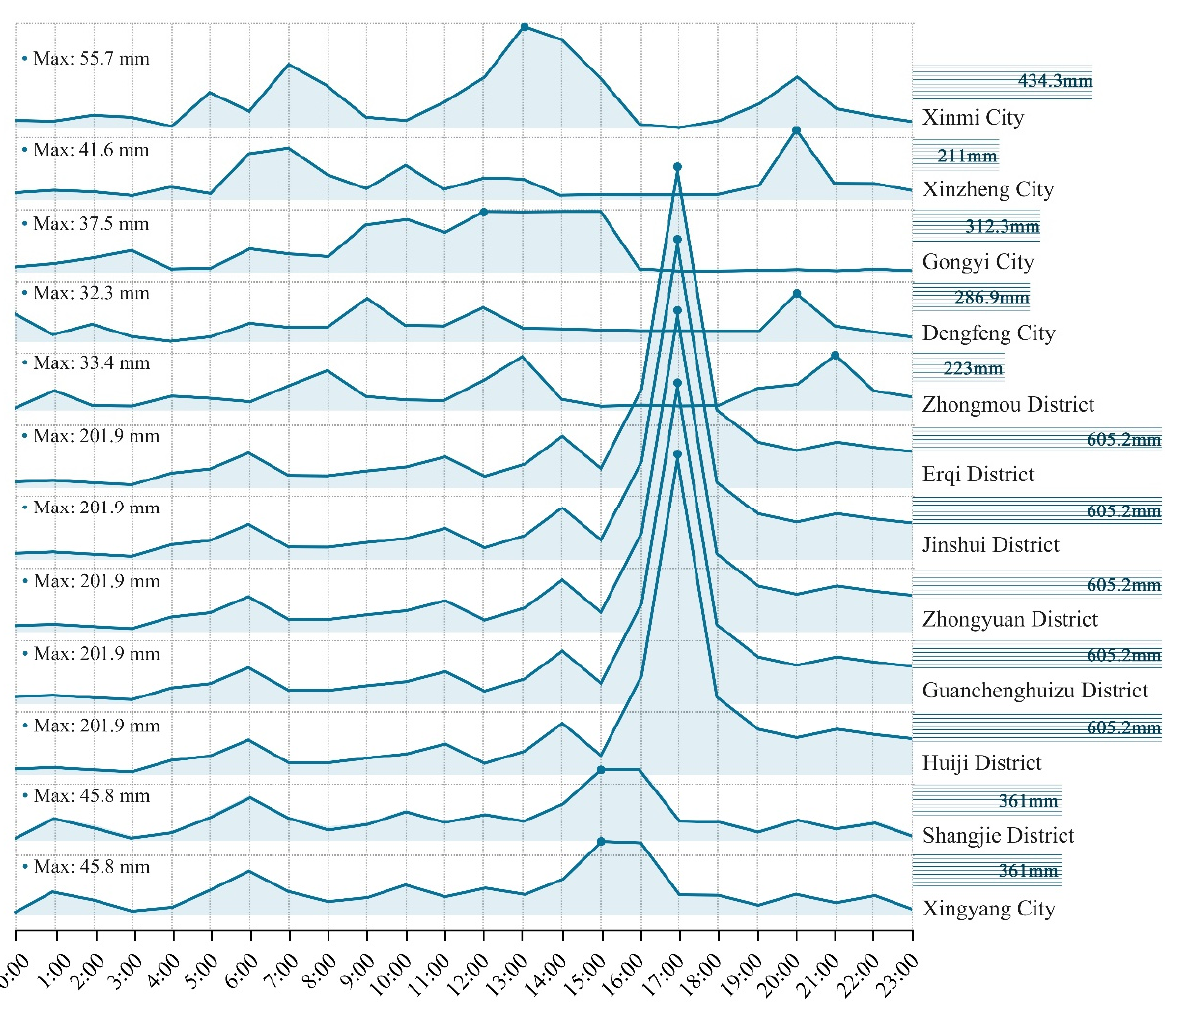
Figure 2. Precipitation from 0:00 ‒ 23:00 on 20 July 2021, in each administrative region of Zhengzhou Figure City.